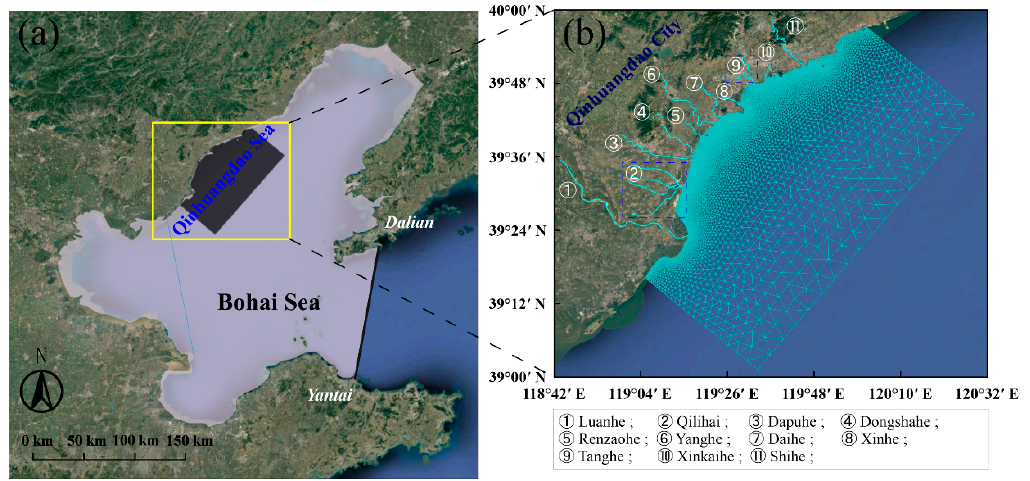
Figure 1. ( a ) Location of the Bohai Sea with the offshore tidal modeling boundary from Dalian to Yantai and Qinhuangdao (QHD) highlighted by the square box; ( b ) Zoomed-in view of computational mesh of numerical model for QHD and 11 seagoing rivers.